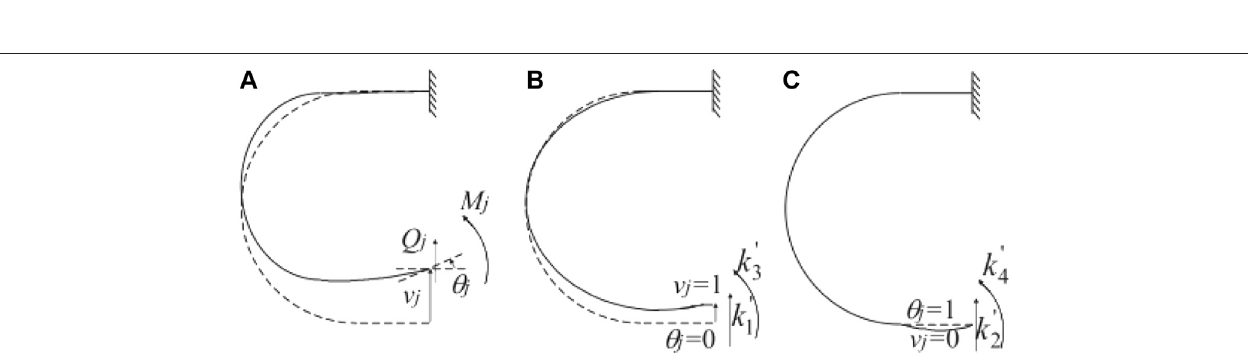
FIGURE 3 | Force by unit displacement at the member end for Model II. (A) Load and boundary conditions. (B) Modi fi cation of the mechanical model.